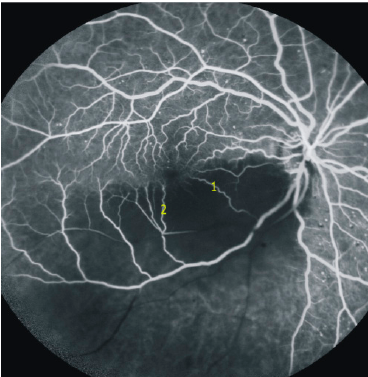
Figure 3. Retinal angiogram image (Figure 3) as a courtesy of Dr. Jeremy Chess, New York. Note the occluded retinal artery branch (black vessel in the inferior temporal quadrant). The functioning